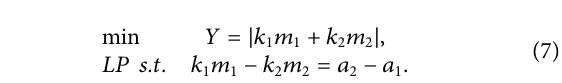
Frontiers in Environmental Science |